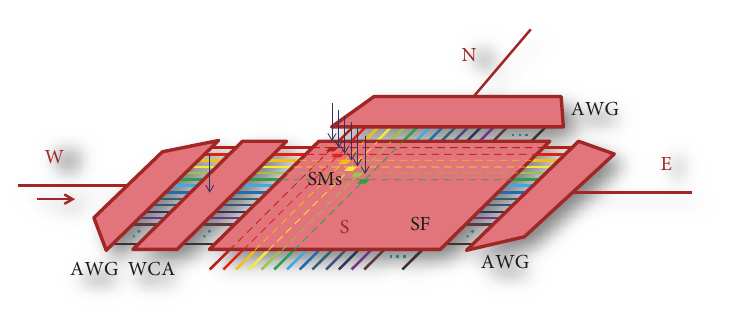
Figure 5: Structure of one of the layers constituting each reconfigurable optical add-drop multiplexer (ROADM).